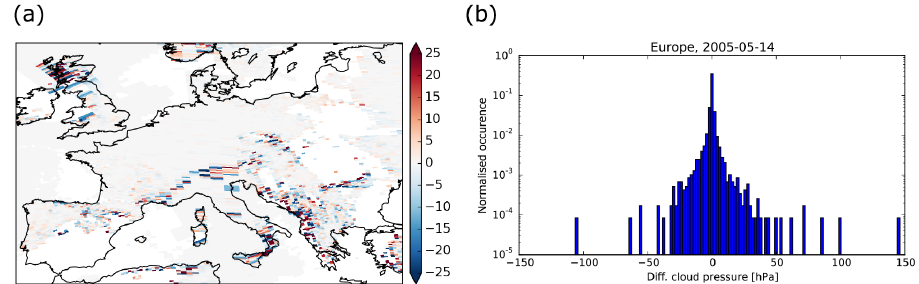
Figure 8. Difference in the effective cloud pressure (old DEM minus new DEM) for effective cloud fractions exceeding 0.1 over Europe for 14 May 2005. Left panel: map of the differences over Europe; right panel: histogram of the differences over Europe on a logarithmic scale.